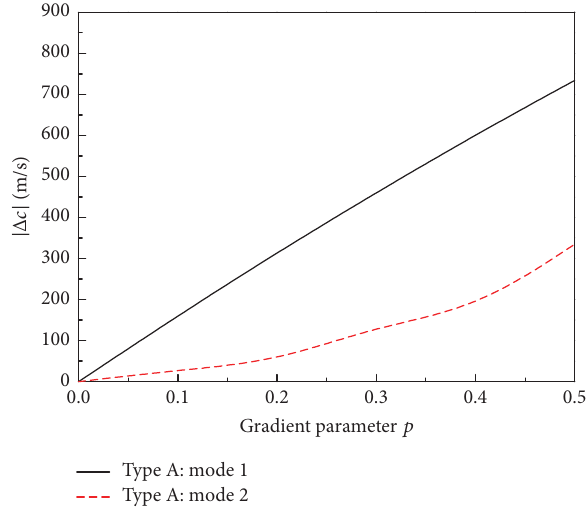
Figure 4: The influence of gradient parameter on the increment of phase velocity with subsurface damage Type